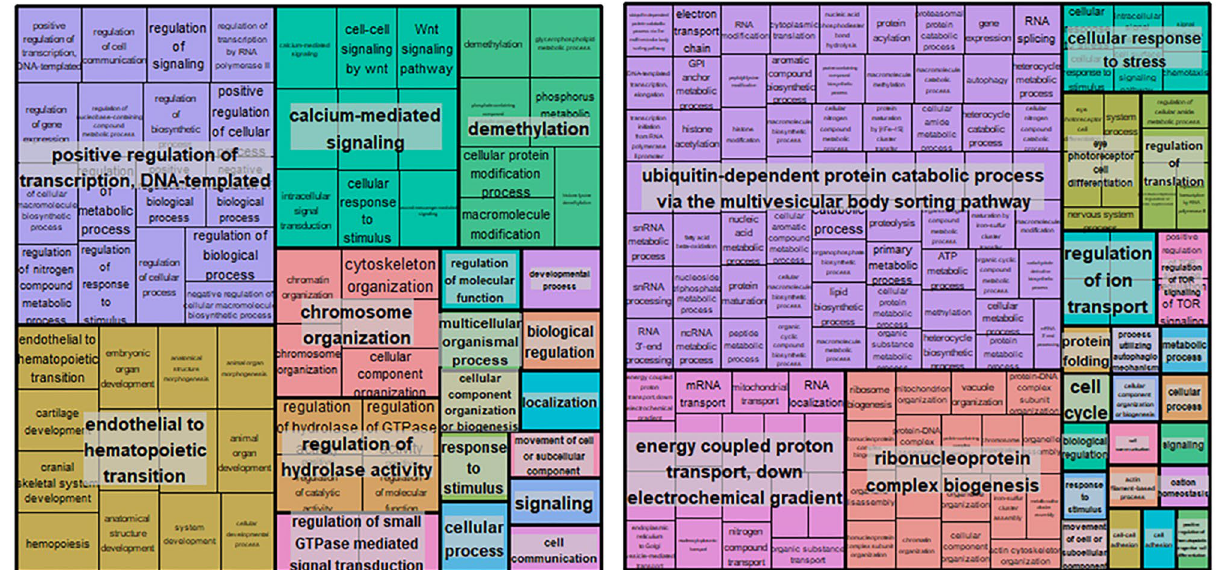
Figure 4. Treemap of the downregulated GO term (left) and upregulated Goterm (right). The nested rectangles, representing the branches of the tree, are not scaled. See Tables S3 and S4 for p -values and fold changes, as well as details of the names and